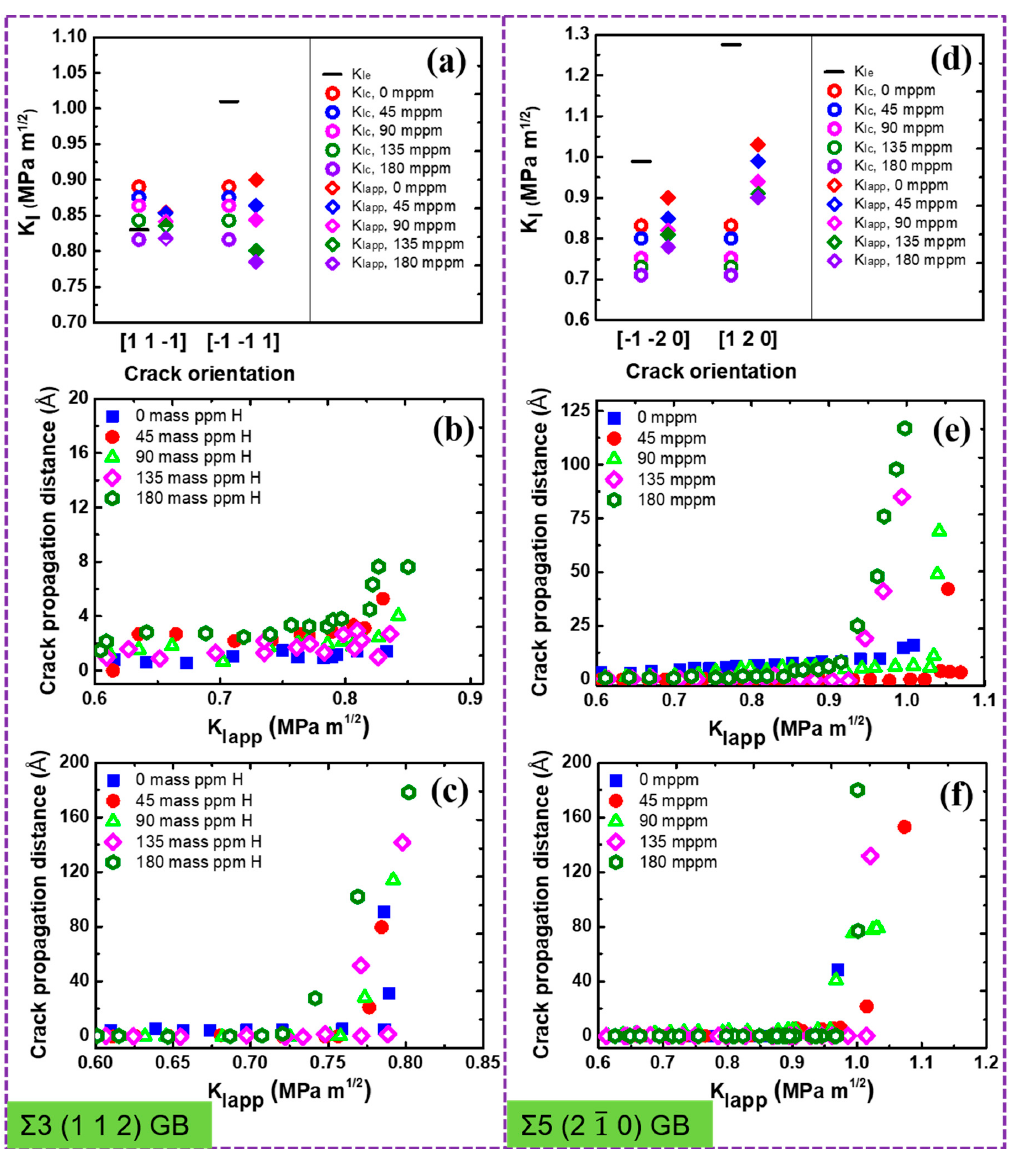
Figure 5. ( a , d ) Overview of critical stress intensity factors K Ie and K Ic , and the global applied stress intensity factor K Iapp in dependence on the crack orientation and H concentration. The partially filled diamonds indicate ductile emission, while solid diamonds indicate brittle cleavage. Crack propagation distance versus the stress intensity K Iapp with various H concentrations along ( b ) [ 1 1 1(cid:3364) ] direction, ( c ) [ 1(cid:3364) 1(cid:3364) 1 ] direction, ( e ) [ 1(cid:3364) 2(cid:3364) 0 ] direction, and ( f ) [ 1 2 0 ] direction.